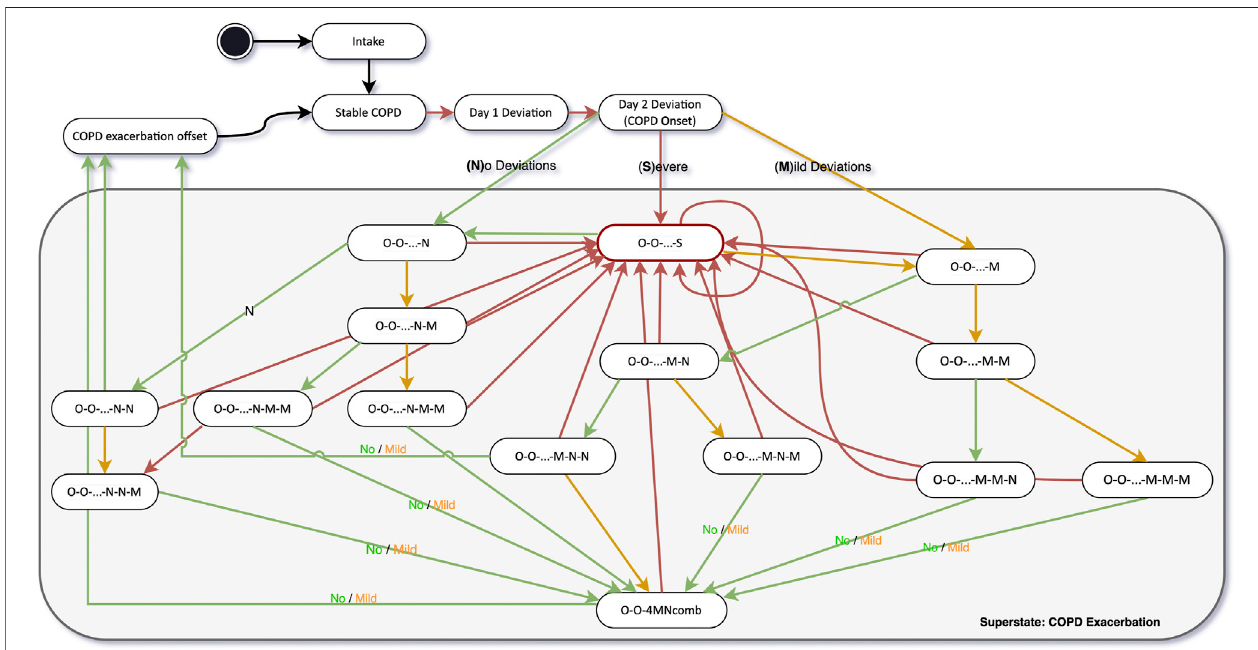
FIGURE 7 | Simpli fi ed clinical pathway diagram of the COPD digital therapeutics